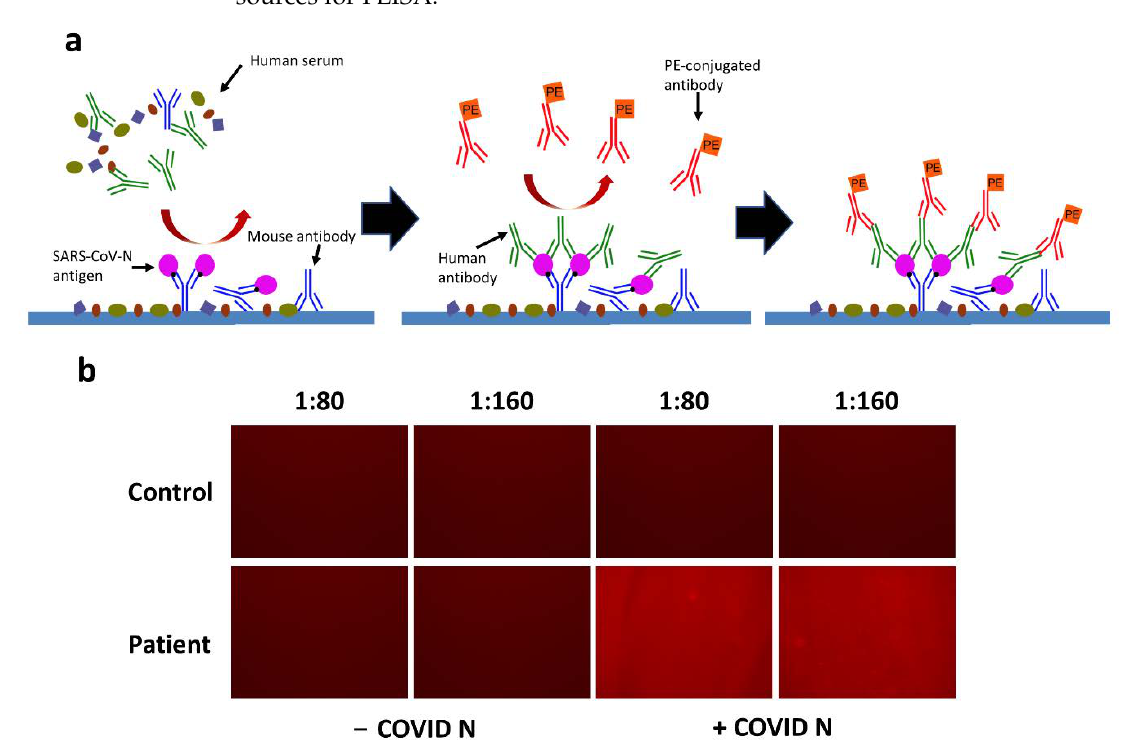
Figure 3. Demonstration of FLISA for sensing antibodies to SARS-CoV-2. ( a ) Schematic diagram of FLISA for sensing antibodies to SARS-CoV-2. ( b ) Photos of PE fluorescence in a fluorescence microscope. The human serum was diluted in 1:80 and 1:160. Comparisons were made between control and patient groups or non-expressed SARS-CoV-N (- − COVID N) and SARS-CoV-N (+COVID N) groups.